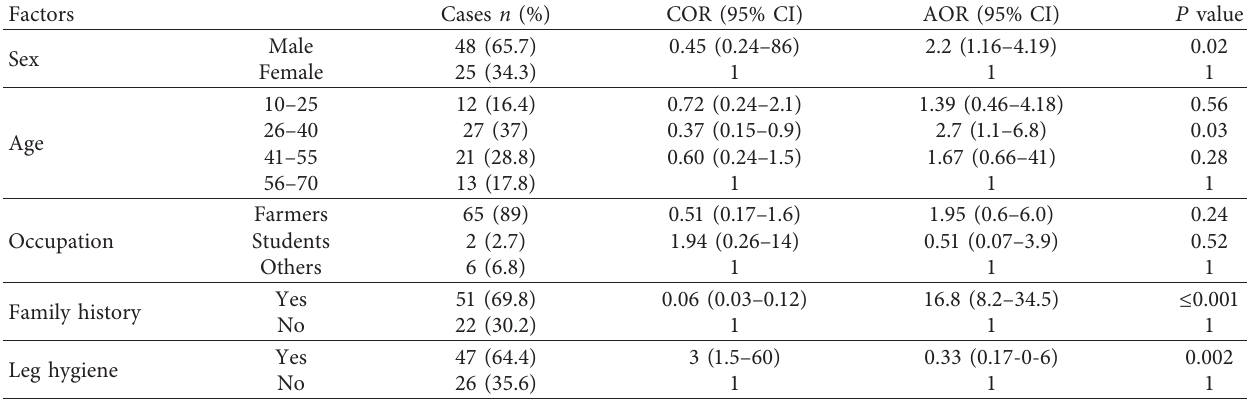
Table 7: Multivariate logistic regression analysis of associated risk factors of podoconiosis cases ( n � 73) in Jeldu district, West Shoa, Ethiopia.